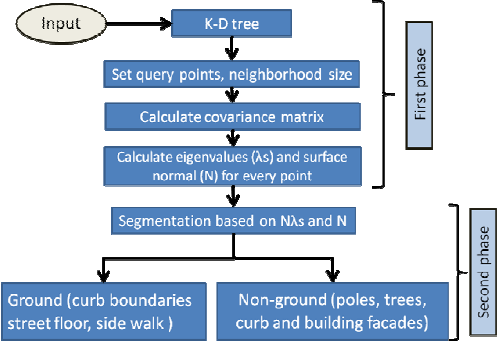
Figure 3. Pipeline of the first and second phases.